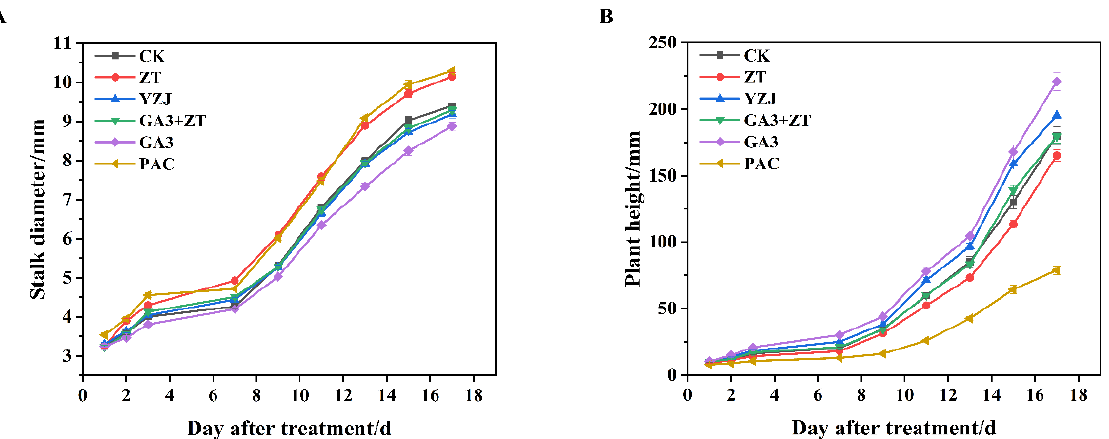
Figure 1. Effect of plant hormones spraying on the growth of flowering Chinese cabbage. ( A ) Stalk diameter. ( B ) Plant height. We measured the stalk thickness and plant height at 1 day after treatment. The units on the lower axis are the number of days after treatment in ( A , B ). The data represent an average of three replicates ± standard error.